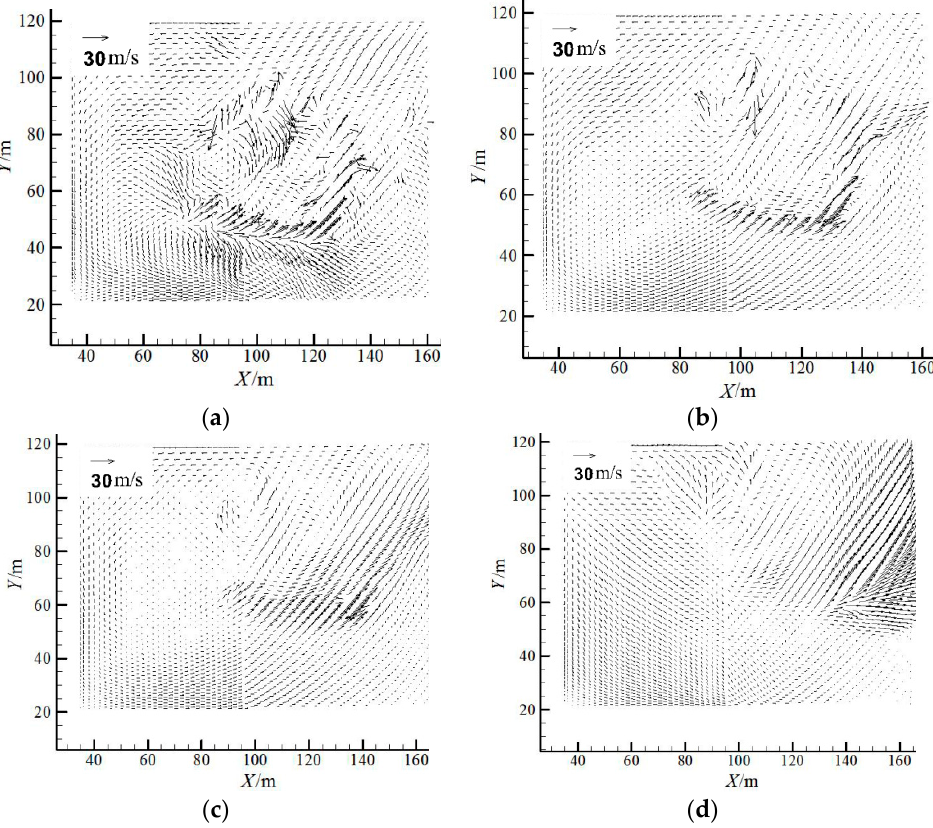
Figure 11. Velocity vector distributions in the plunge pool: ( a ) Z = − 38 m; ( b ) Z = − 44 m; ( c ) Z = − 50 m; ( d ) Z = − 58 m.